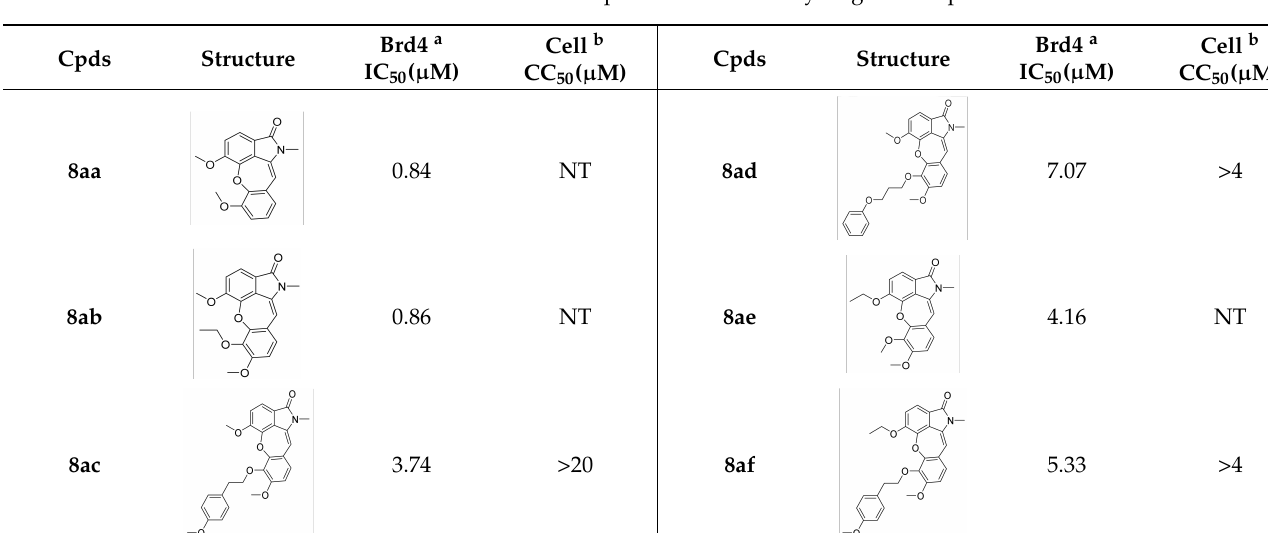
Table 1. Inhibition effects of compounds fixed with hydrogen at R 4 position.